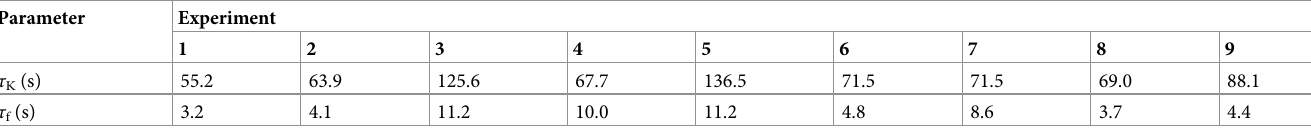
and τ used for the fit of each experiments. K f